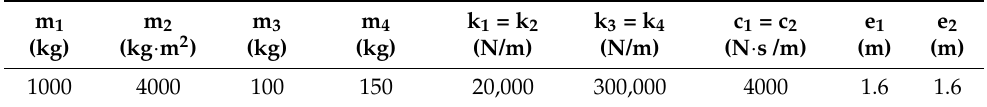
Table 1. Parameters values of the vehicle model.